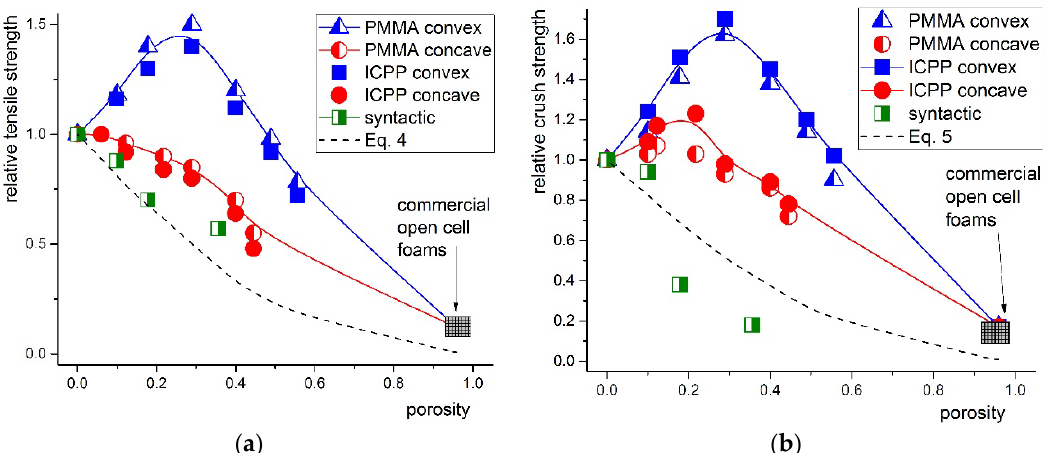
Figure 7. ( a ) Dependence of the tensile strength of cellular composites with gradient porosity and commercial syntactic foams on the relative porosity. ( b ) Dependence of the crush strength of gradient porosity foams and commercial syntactic foams on the relative porosity (compressive loading in the direction of density gradient). Dashed line represents the Ashby–Gibson models (Equation (3) and Equation (4)). Data for commercial soft open cell foams are shown in the meshed